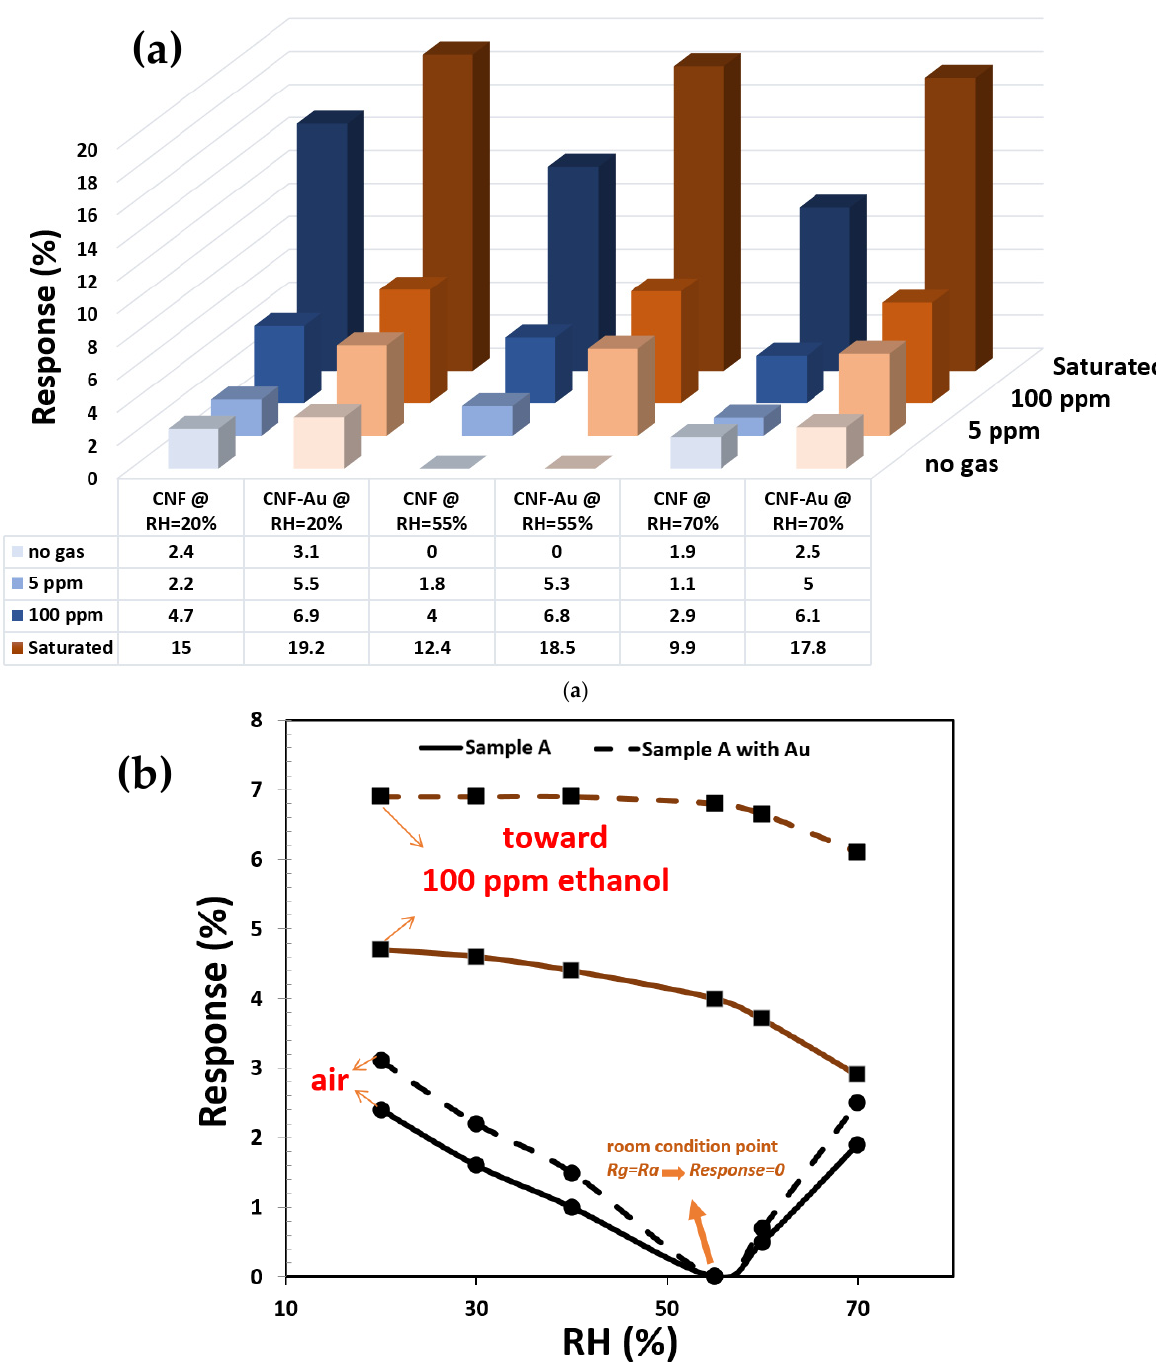
Figure 9. ( a ) Response of CNF-based sensor in presence of different concentrations of ethanol vapor and different variation of relative humidity at room temperature (the blue and brown spectrum represent CNF and decorated CNF, respectively). ( b ) Response of sample A in air and presence of 100 ppm concentration of ethanol vapor toward variation in relative humidity at room temperature.